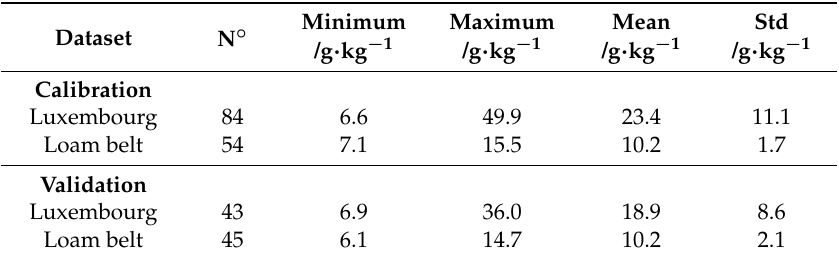
Table 2. Descriptive statistics of the soil organic carbon content in the calibration and validation dataset of the loam belt and Luxembourg areas.